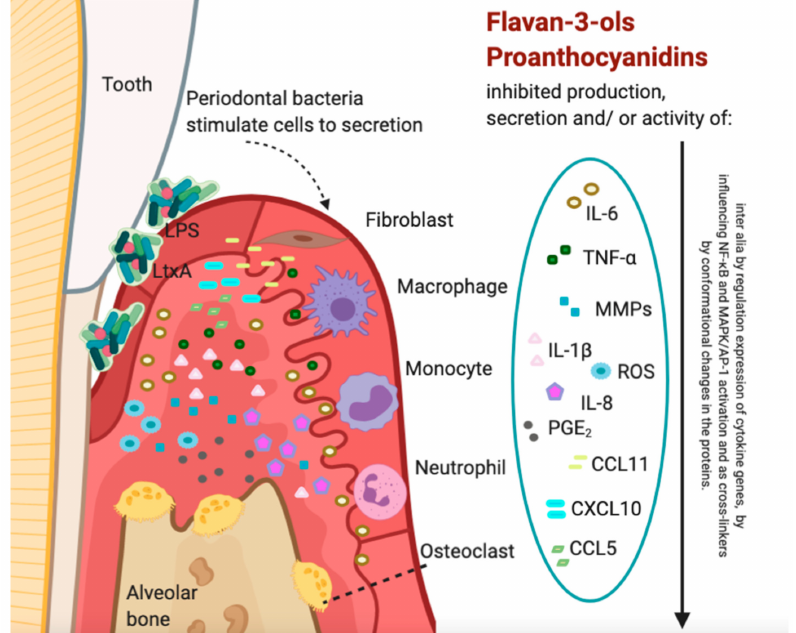
Figure 1. Schematic picture illustrating immunomodulatory activities of flavan-3-ols and proanthocyanidins in periodontitis. Some of the more important cytokines are shown in the figure. The figure was created using BioRender.com. Abbreviations shown in the figure: IL, interleukin; TNF- α , tumor necrosis factor α ; MMP, matrix metalloproteinases; ROS, reactive oxygen species; PGE 2 , prostaglandin E 2 ; CCL, C-C motif chemokine ligand; CXCL, C-X-C motif chemokine ligand; LPS, lipopolysaccharide; LtxA, Leukotoxin released by A. actinomycetemcomitans